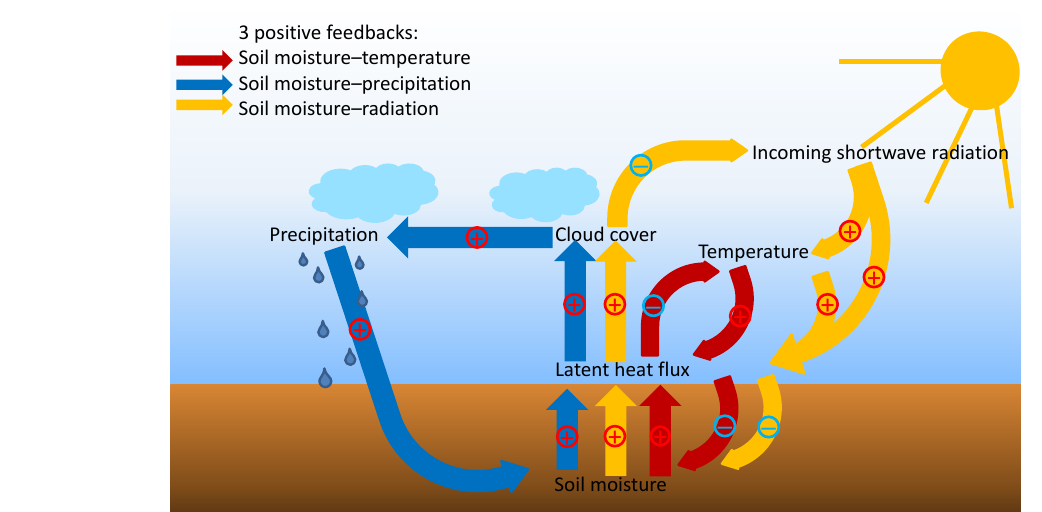
Figure 9. Soil moisture–atmosphere feedbacks. The plus and minus indicate positive and negative feedback loops, respectively. The colors show the soil moisture–temperature (red), the soil moisture–precipitation (blue) and the soil moisture–radiation (yellow) feedback